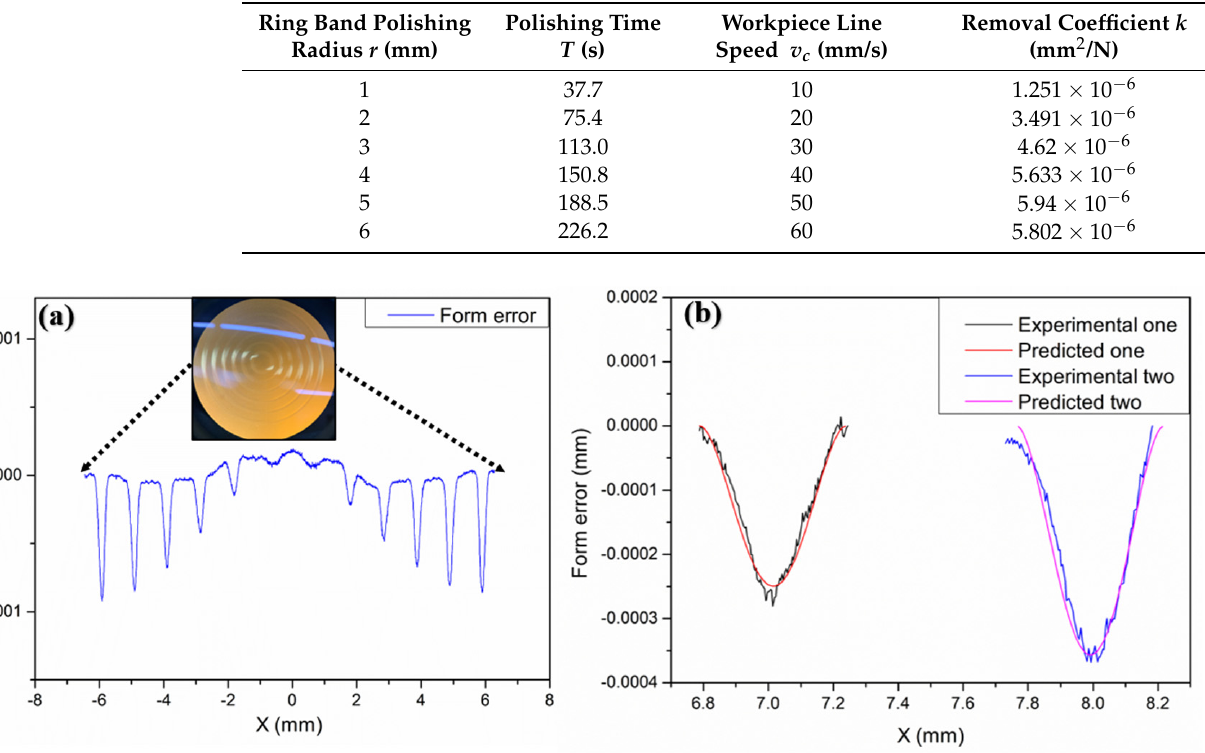
Figure 10. ( a ) Experimental contour survey of ring band; ( b ) Profile shape comparison of experimental and theoretical model.